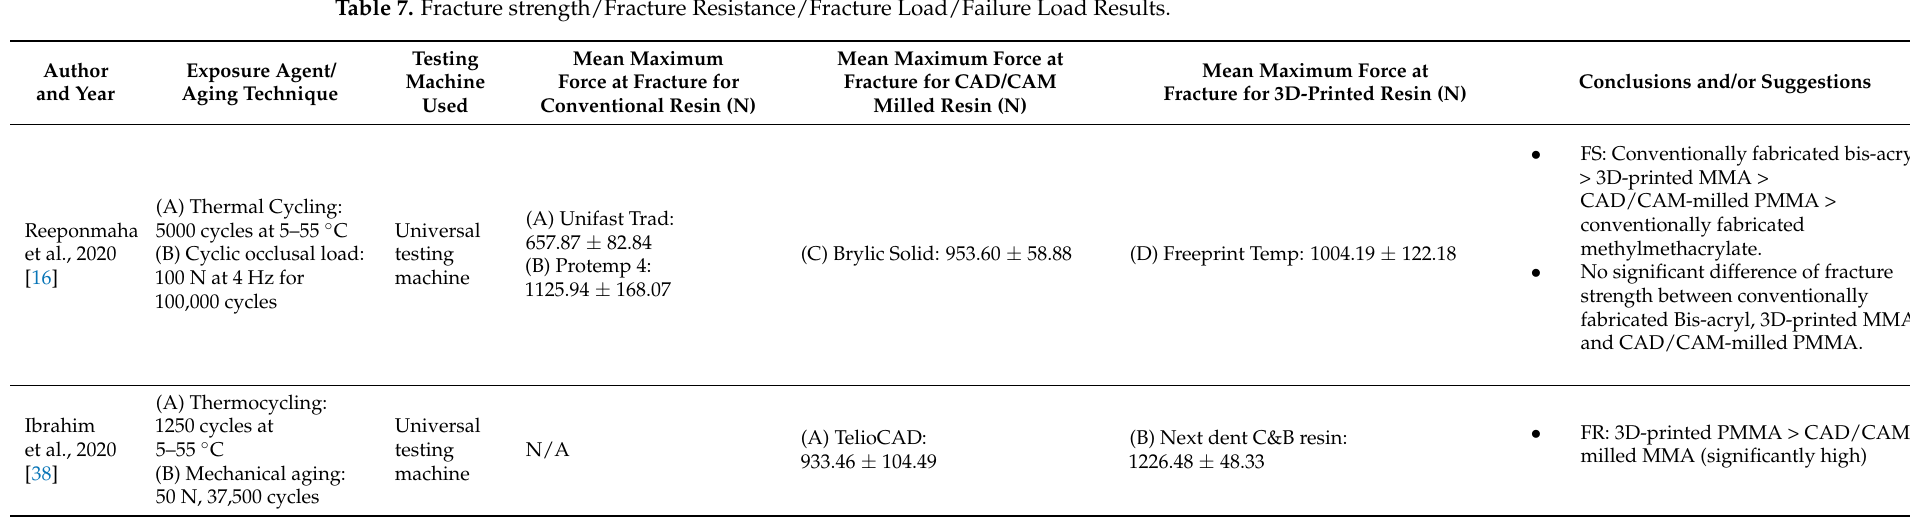
Table 7. Fracture strength/Fracture Resistance/Fracture Load/Failure Load